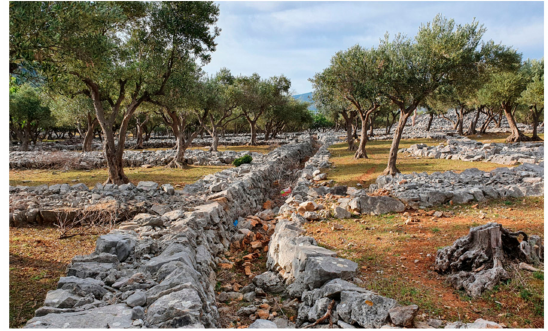
Figure 20. The drainage system within the Cres olive grove consists of dry stone channels which gather the water from the terraces, thus avoiding the rainfall to damage the yield (Tanja Kremeni´c, 2020).